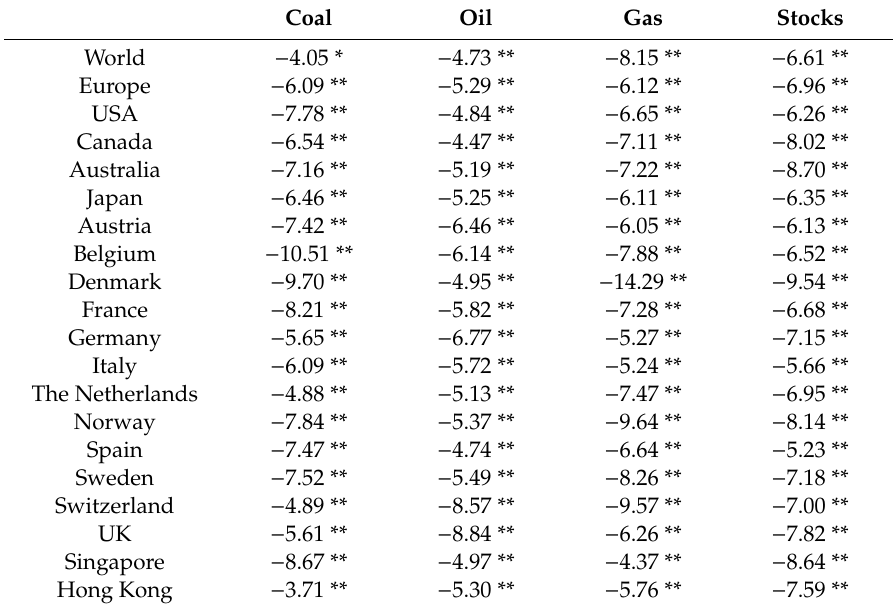
Table 2. Augmented Dickey–Fuller (ADF) test for relative changes in CO2 emissions from coal, oil and gas, and MSCI stock returns.